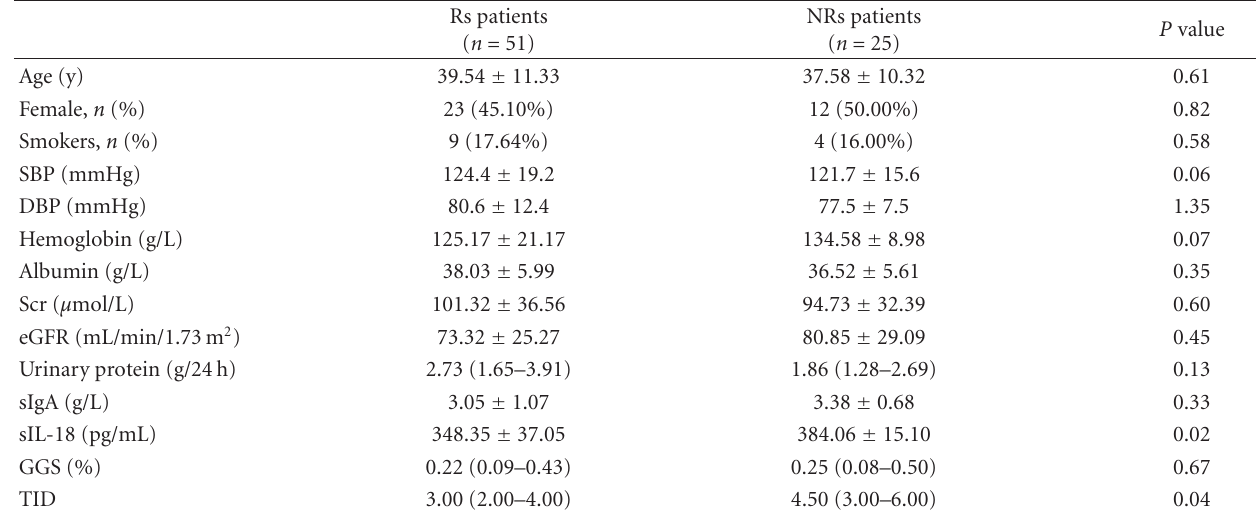
Table 2: Clinical and histological data in Rs and NRs patients.